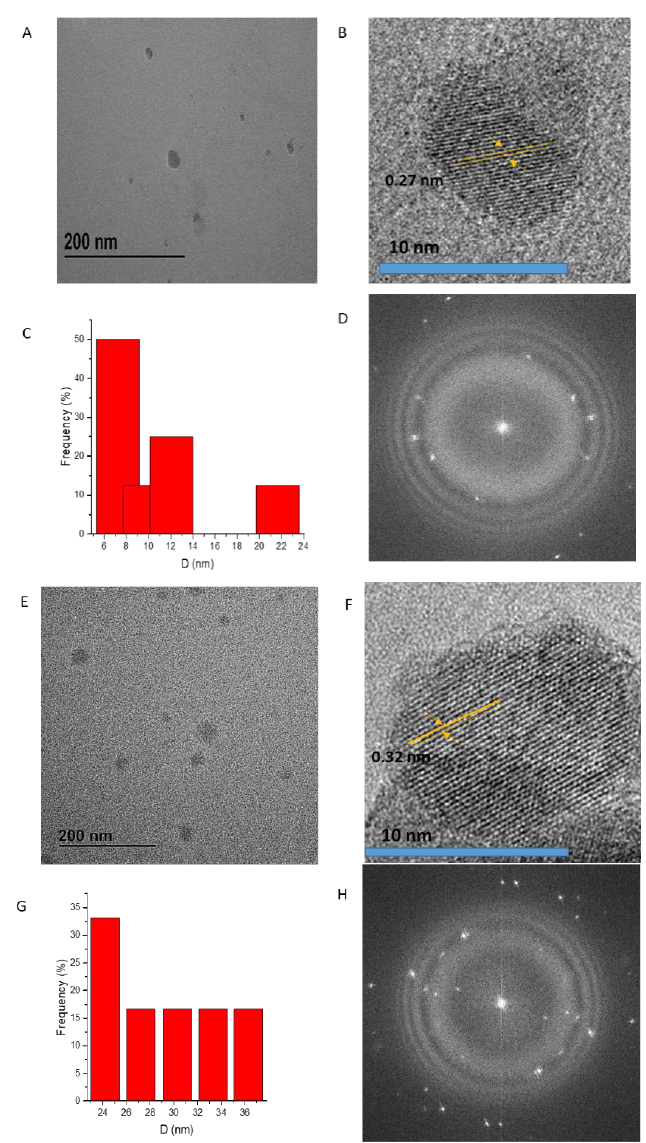
Figure 13. Transmission electron microscopy (TEM), selective area electron diffraction (SAED), and particle size distribution histograms for sodium citrate@ CF-MNPs ( A – D ) and sodium citrate@ ZCF-MNPs ( E – H ).